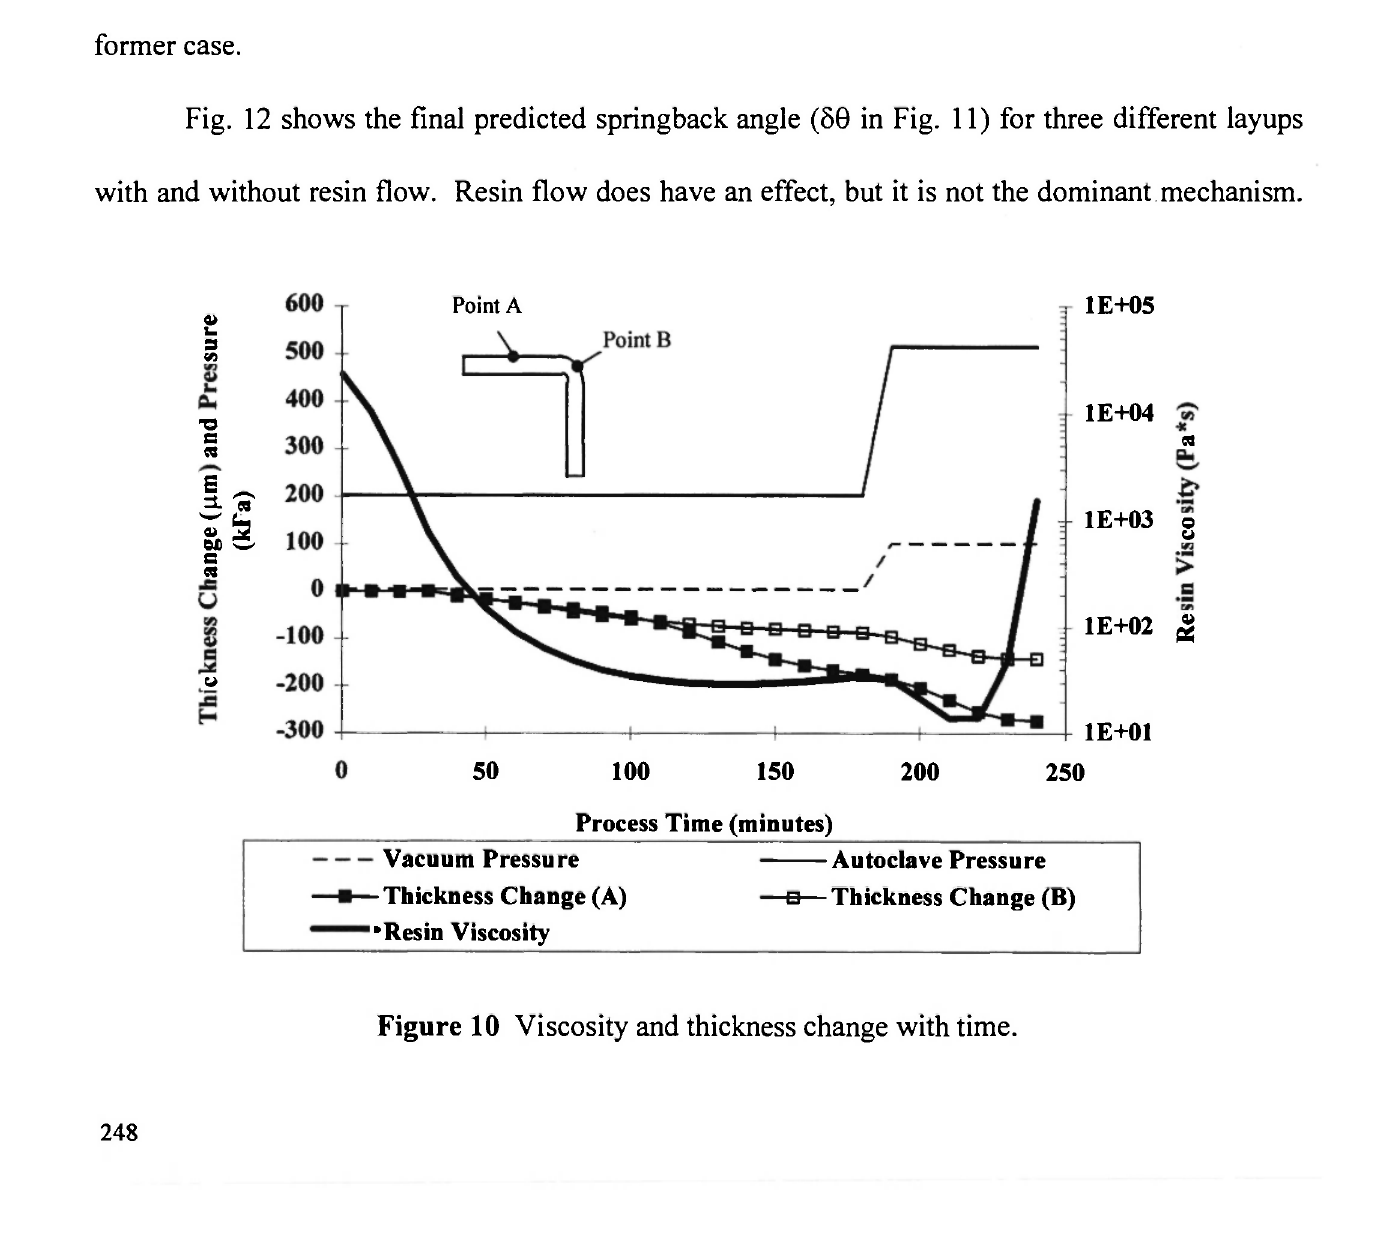
Figure 10 Viscosity and thickness change with